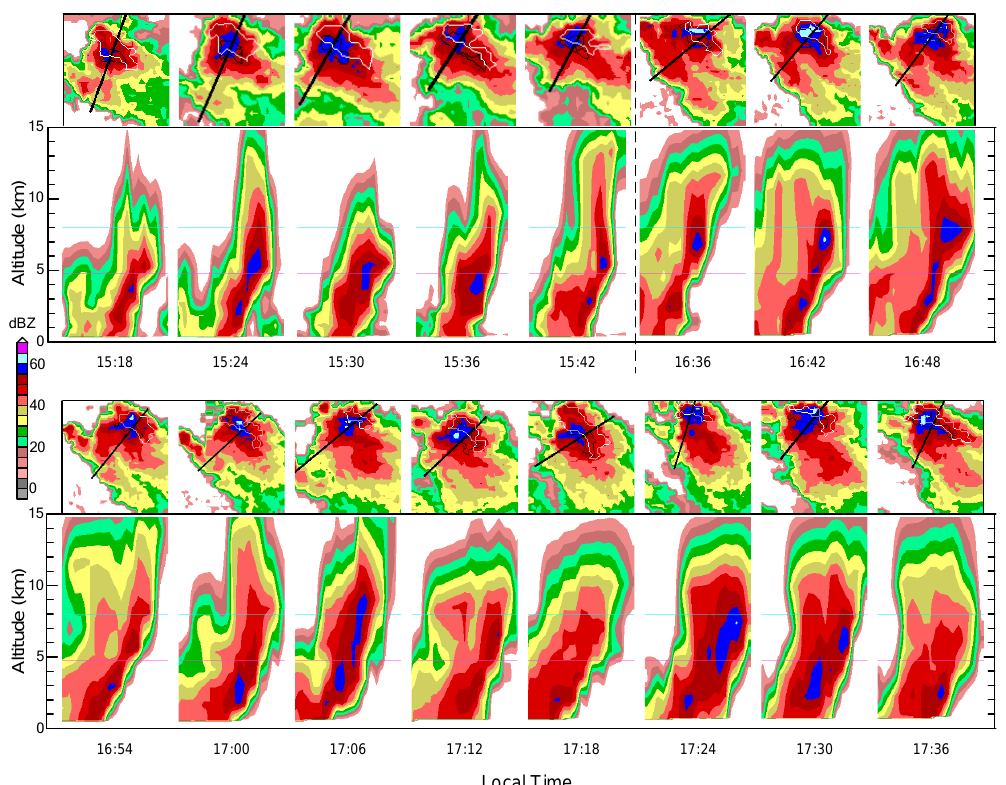
Figure 16. Composite reflectivity images (above) and vertical cross-section images generated automatically by the algorithm (below) of cells at each time step of Case 2 (27 July 2015). Images are superpixel-interpolated. In each composite reflectivity image, the black line is the cross-section line, and white and black contours are the locations of overhang echoes and tilted wall echoes, respectively. In each cross-section image, horizontal pink and blue lines refer to the melting layer and respectively.